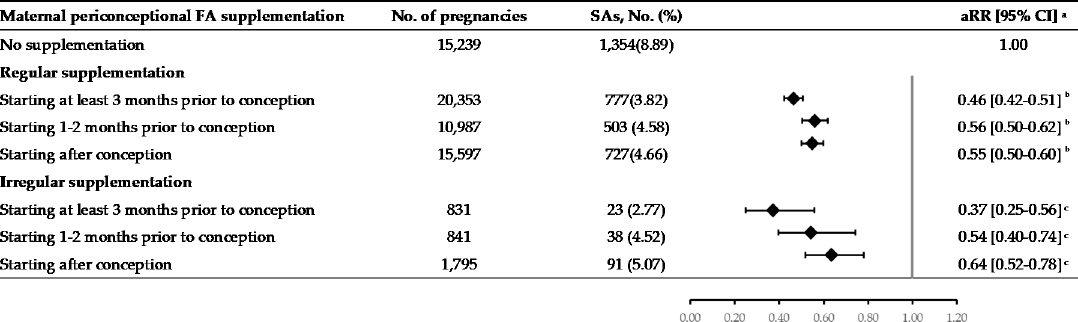
Figure 2. Subgroup analysis on the association between maternal periconceptional folic acid (FA) supplementation and the risk of spontaneous abortion (SA) according to compliance to supplementation and the initiation timing of supplementation. a The RRs were adjusted for maternal age, ethnicity, education, employment, household, registration, year and area of recruitment, BMI, passive smoking before pregnancy, parity, history of complicated pregnancies, chronic diseases, birth defects or history of a birth defect in a previous delivery, and husbands’ smoking in early pregnancy. b The aRR for FAS initiated 3 months or more prior to conception and risk of SA was significantly lower than that for FAS initiated 1–2 months prior to conception ( χ 2 = 11.29, p = 0.0011) or after conception ( χ 2 = 10.59, p = 0.0011). c The aRR for FAS initiated 3 months or more prior to conception was significantly lower than initiated after conception ( χ 2 = 5.53, p = 0.0187). aRR, adjusted risk ratio; CI, confidence interval.